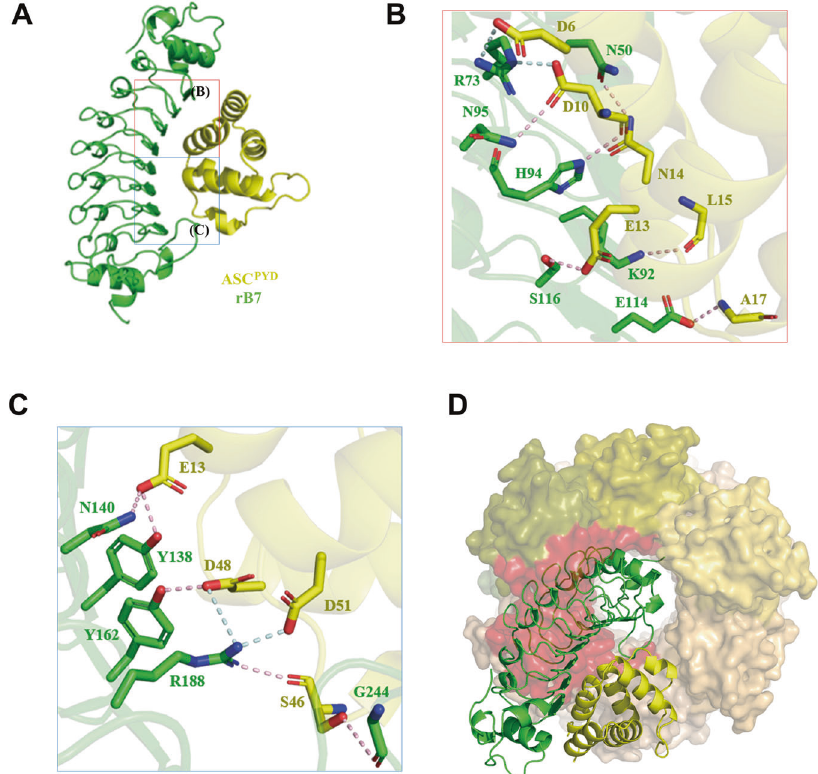
Fig. 3 Structural basis for inhibition of ASC oligomerization by rB7. A One protomer structure of rB7 in complex with ASC PYD . rB7 and ASC PYD are shown in the cartoon model. Two interaction regions are presented in detail in ( B ) and ( C ). B Hydrogen bonds and salt bridges are shown in dashed lines in the stick model. C Hydrogen bonds are represented in light pink, and salt bridges are represented in pale cyan. D Superimpose of rB7 in complex with ASC PYD on Cryo-EM structure of ASC PYD fi lament (PDB ID: 3J63). rB7 and ASC PYD are presented in the cartoon model, and ASC PYD fi laments are shown in the surface model. Seven molecules of ASC PYD are found nearby, and the steric clash with rB7 is highlighted in